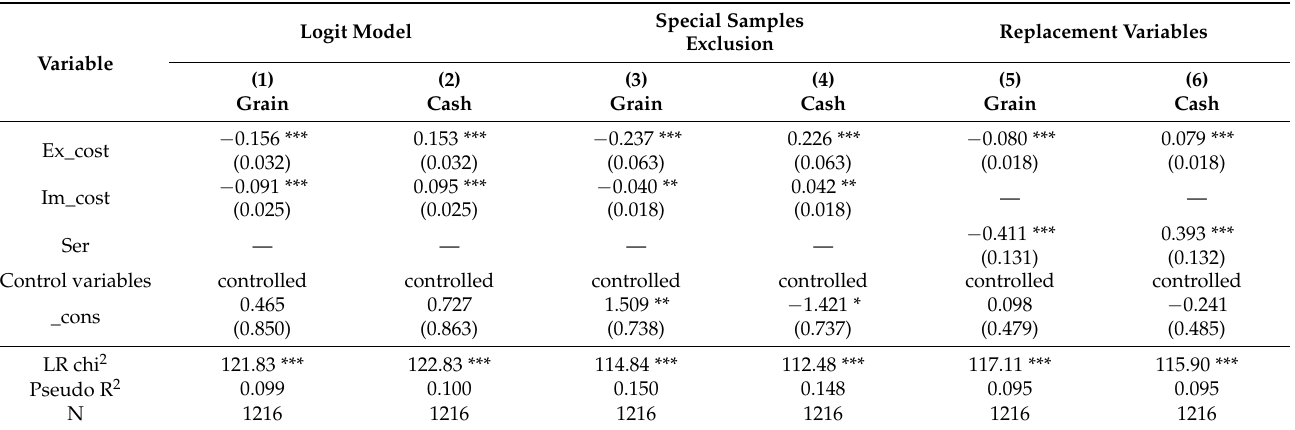
Table 4. Robustness test